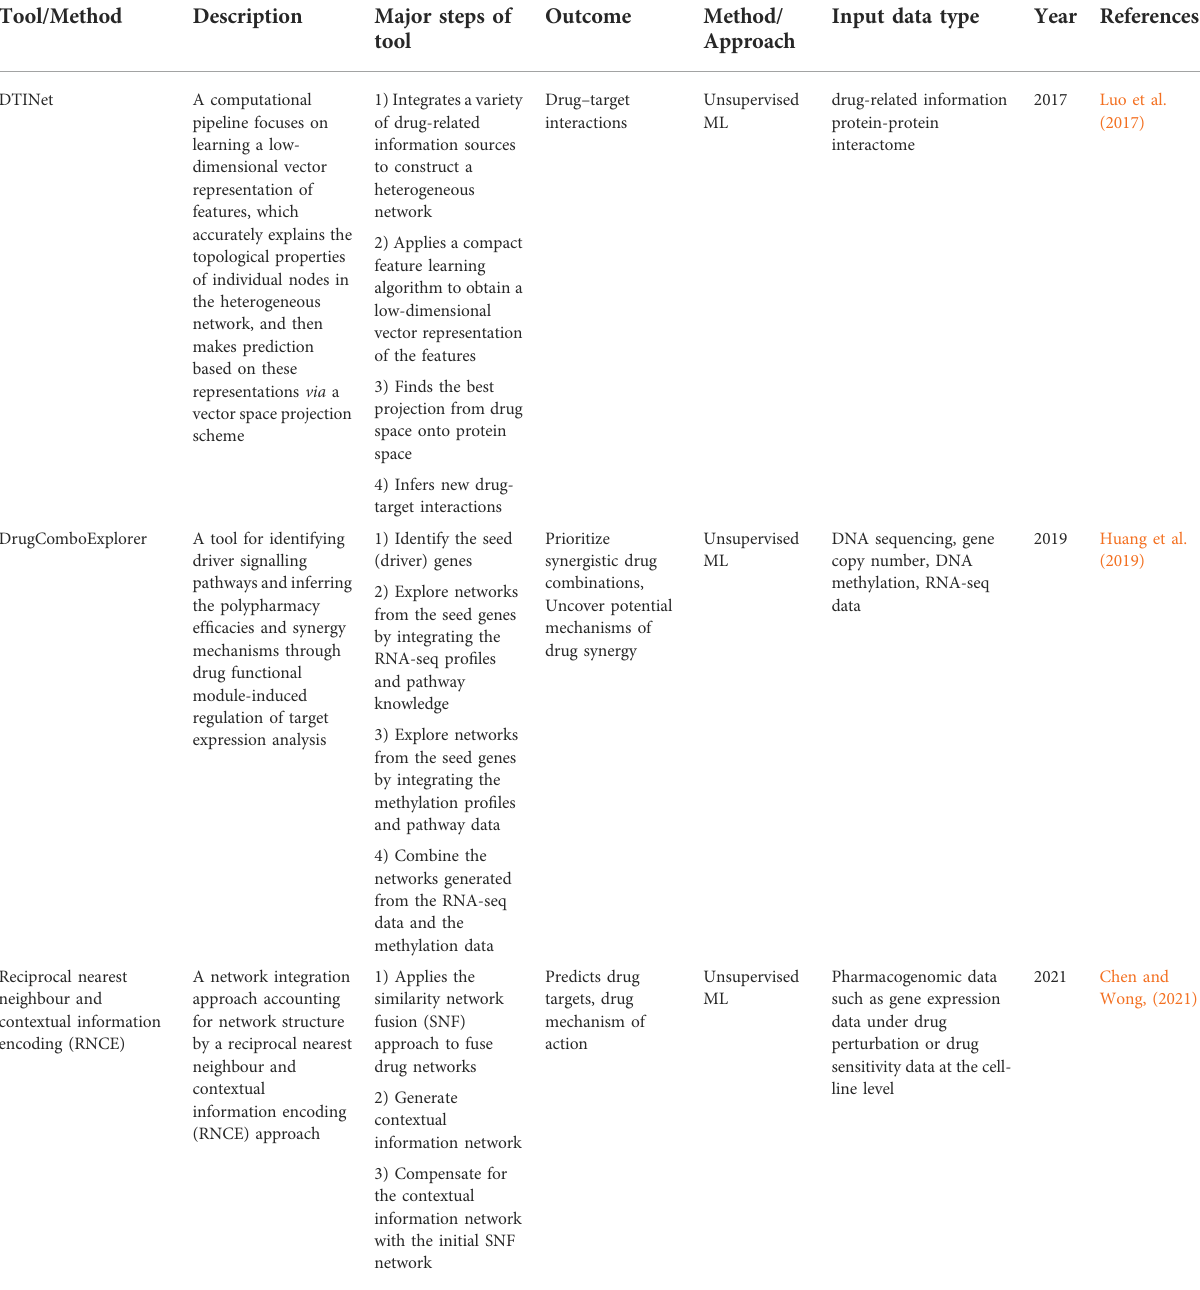
TABLE 2 Useful network-based integrative multi-omics tools for drug discovery.